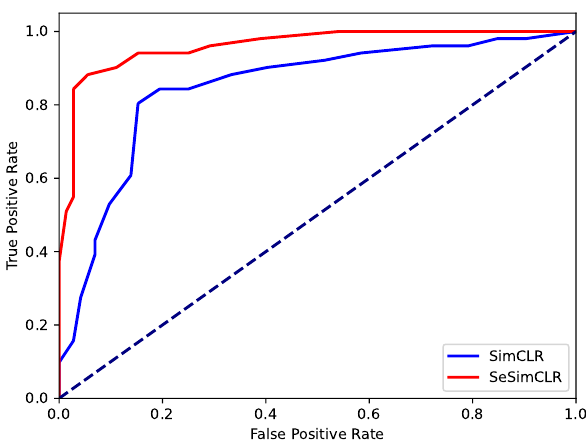
Figure 4. ROC curves. The ROC curves show the classification performance by the proposed workflow with SimCLR or